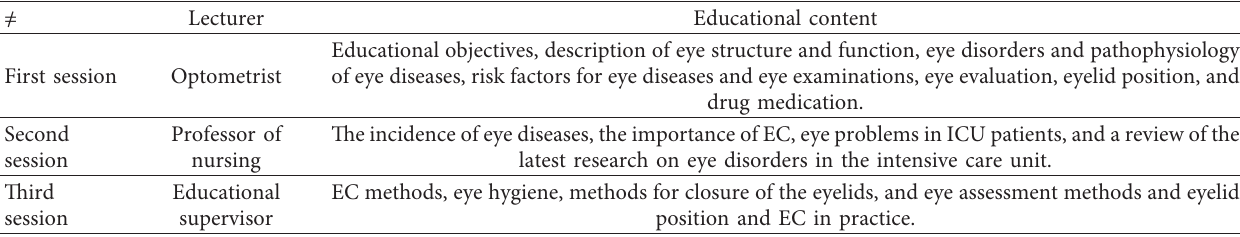
Table 1: Scheduling of EC training session for the experimental group.